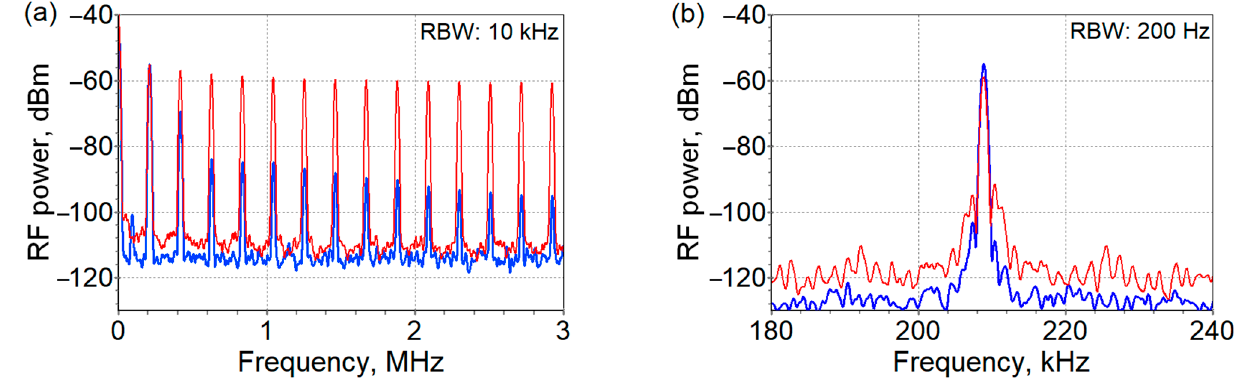
Figure 9. Overlay of the measured RF spectra of the fundamental (blue traces) and Stokes (red traces) pulse trains generated upon a quasi-synchronous pumping with the modulation frequency of 208.8 kHz. ( a ) Low-resolution RF spectra measured across a relatively wide frequency span; ( b ) high-resolution RF spectra measured in the vicinity of the modulation frequency. The RBW specifies the resolution bandwidth used to measure the RF spectra.